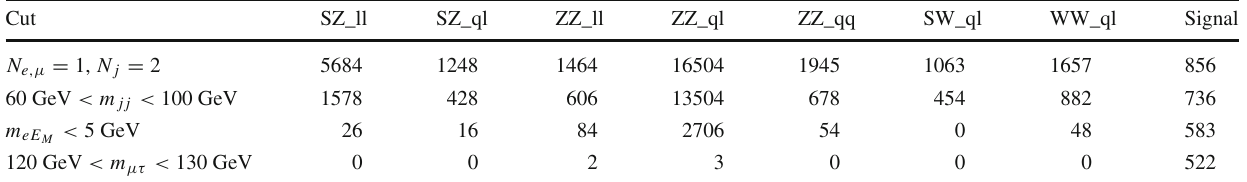
Table 4 The numbers of background events in different categories and signal events surviving the cuts in the analysis of H → μ ± τ ∓ at the CEPC. See text for